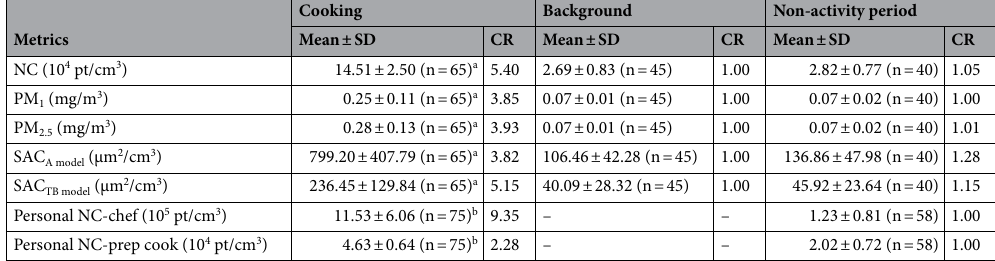
Table 4. Total particle concentrations during cooking, background, and non-activity period. a p < 0.01, as compared with the background. b p < 0.01, compared with the non-activity period.